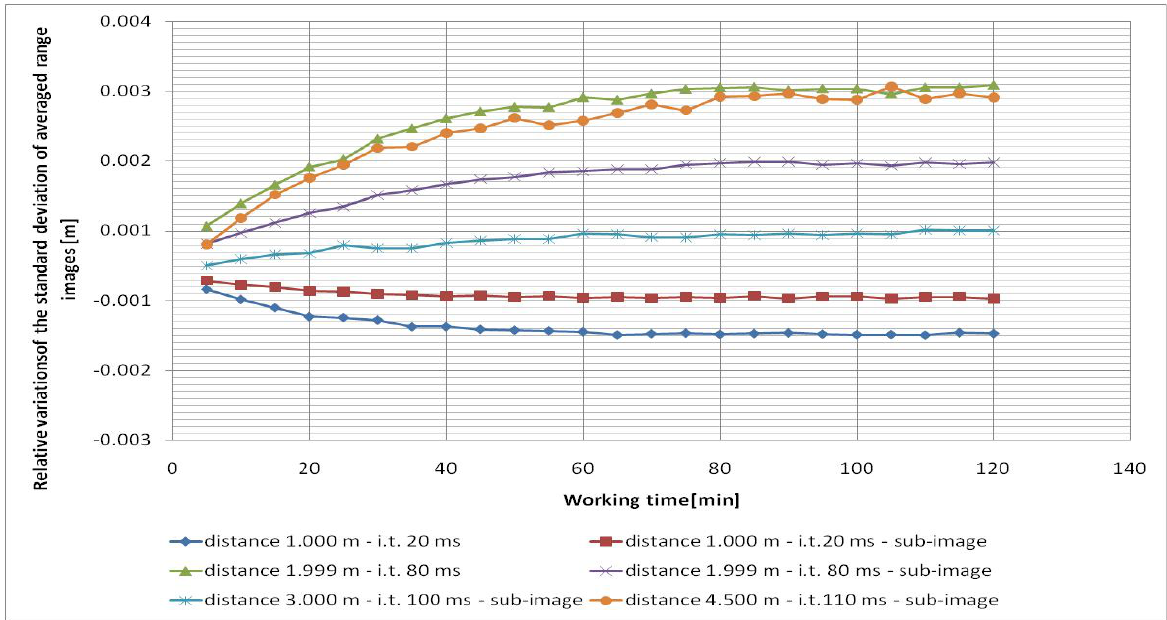
Figure 3. Relative variations of the standard deviation of averaged range images during the working time of several tests (i.t. means integration